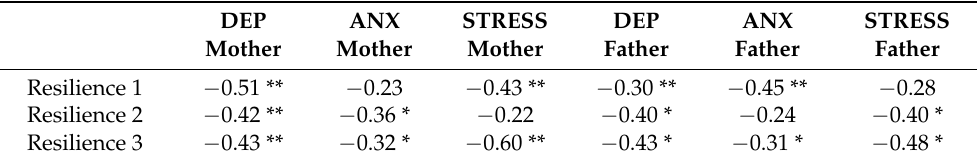
Table 4. Spearman’s ρ correlations between resilience values and the DASS-21 scale scores of mothers and fathers at T0.